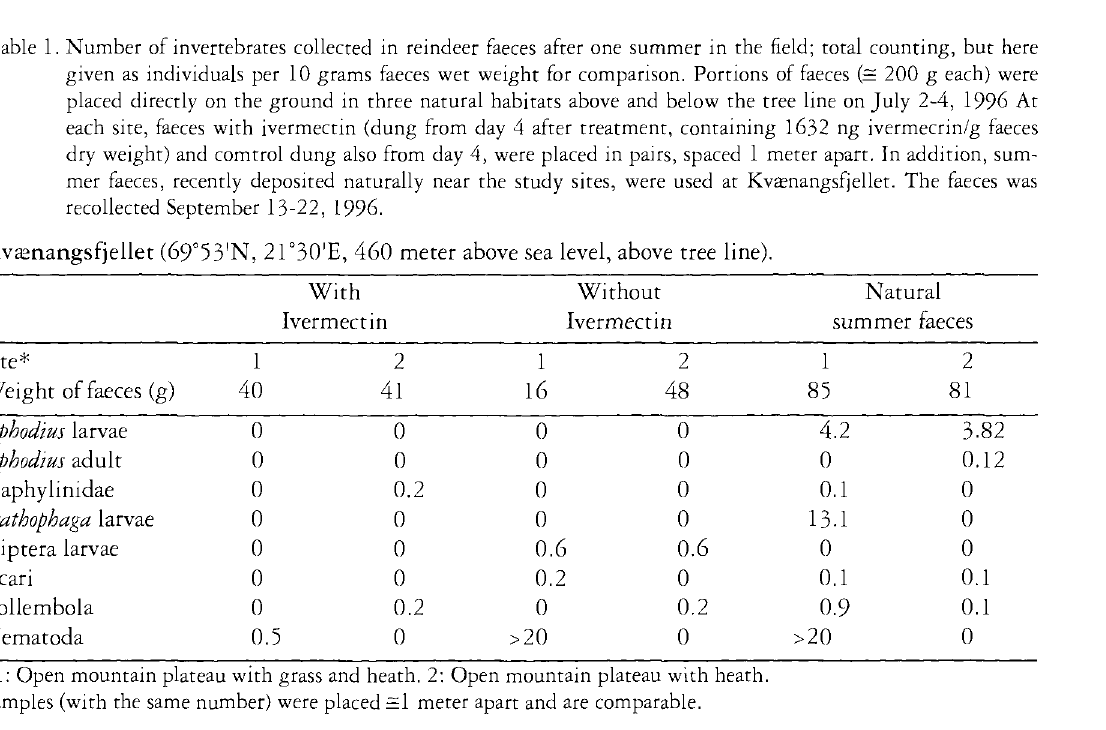
*Both 1 & 2 are birch forest. ** Unidentified, but not Aphodius spp. Samples (with the same number) were placed =1 meter apart and are comparable. 12 to 35